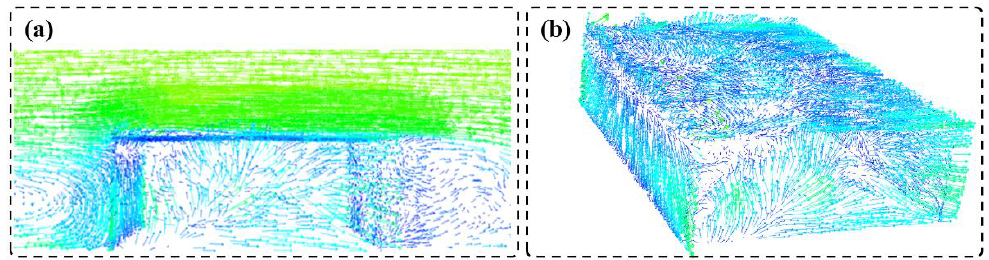
Figure 6. Average wind speed vector diagram of flow field: ( a ) overall flow field; ( b ) TTU model.